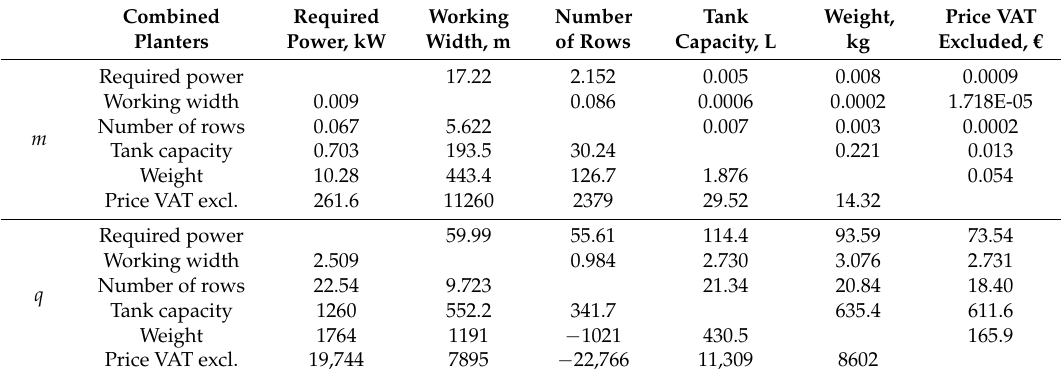
Table 6. Linear coefficient and intercept matrix for functional parameters of combined